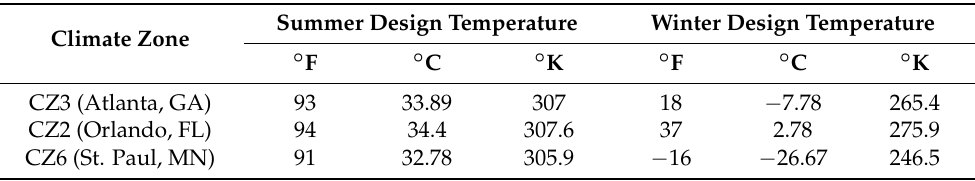
Table 4. Design conditions used in analysis.